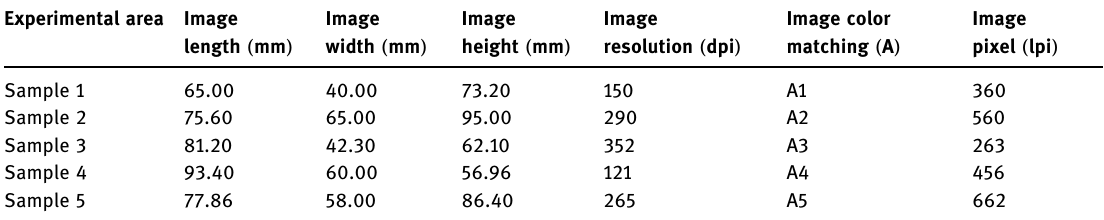
Table 1: Experimental samples